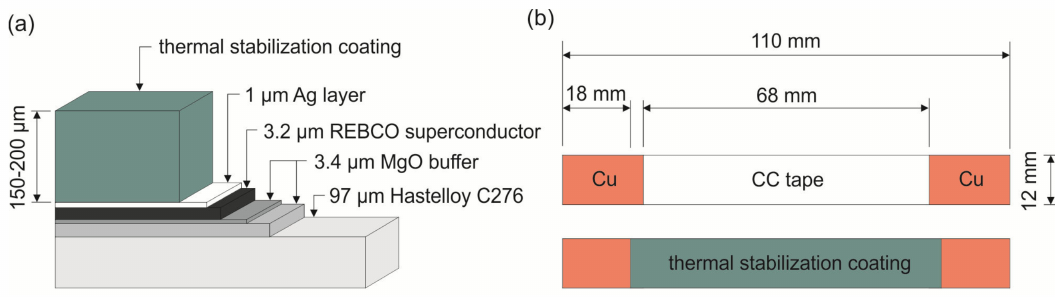
Figure 2. Coated coated (CC) tape samples with coated high- c p layer: ( a ) The layer thicknesses; ( b ) Dimensions of the samples for limitation